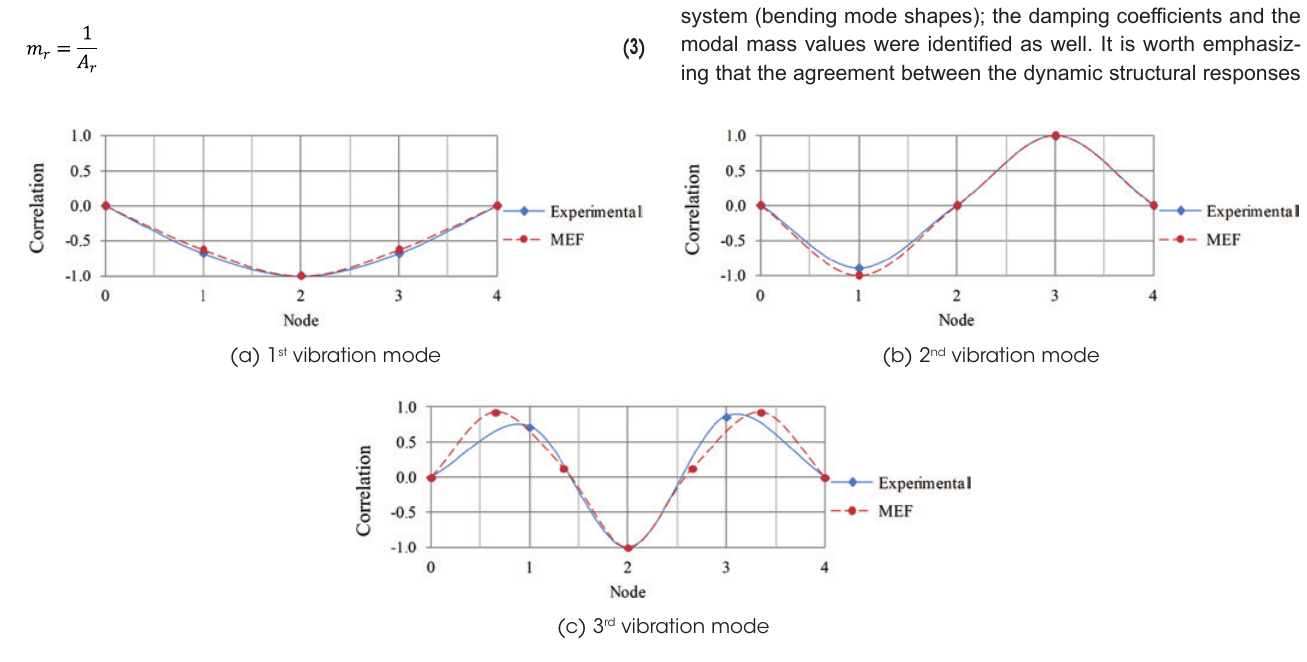
Comparison between the experimental and numerical footbridge mode